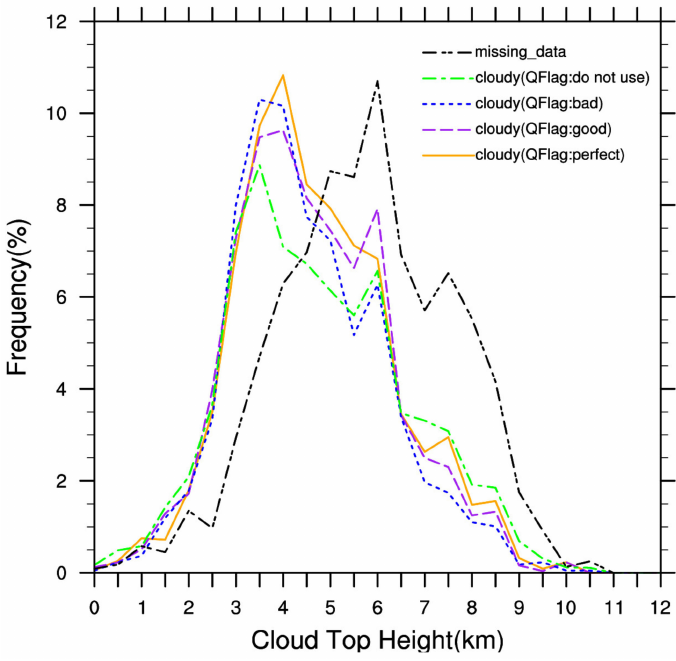
Figure 6. The occurrence frequency of GIIRS temperature profile products with the different cloud top heights under the cloudy sky. The black line represents the missing data. The different quality flags are as follows: perfect (orange line), good (purple line), bad (blue line), very bad or do not use (green